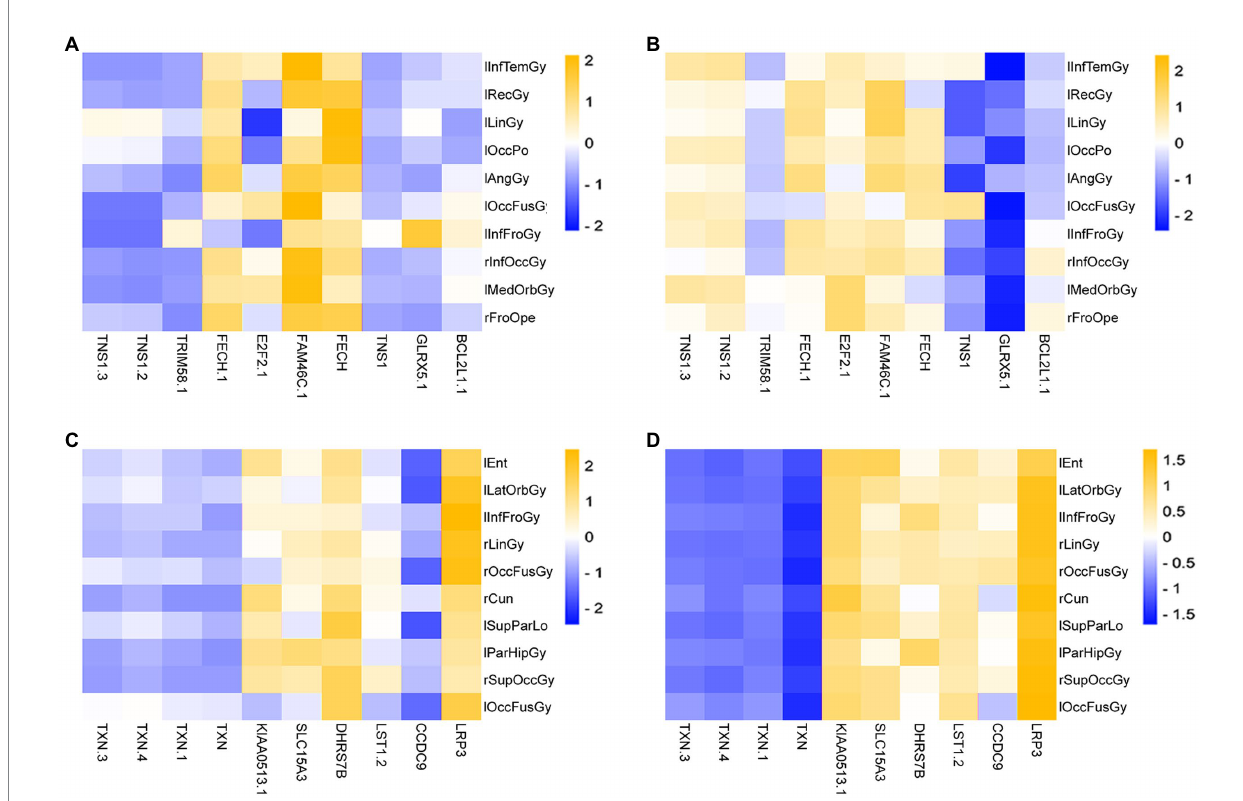
FIGURE 10 Heatmap of the correlation of Top ROIs and genes on the test set. (A,B) Are the correlation heatmaps of AD group and healthy control group, respectively. (C,D) Are the correlation heatmaps of the MCI group and the healthy control group, respectively.